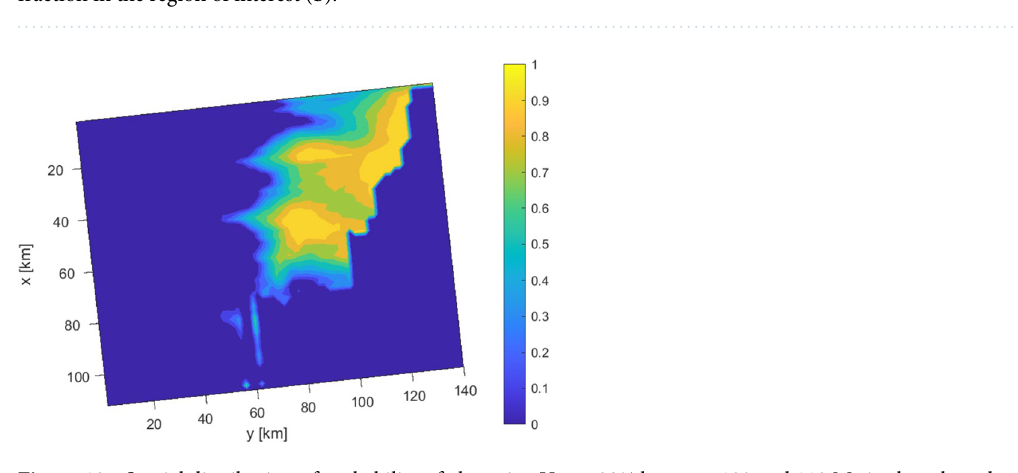
Figure 11. Spatial distribution of the sediment thickness (cid:31) Z 129 113 together with the pinch-out location (black line), black dots identify the region of interest ( a ); marginal distribution of the cumulative volume of sand fraction in the region of interest ( b ).